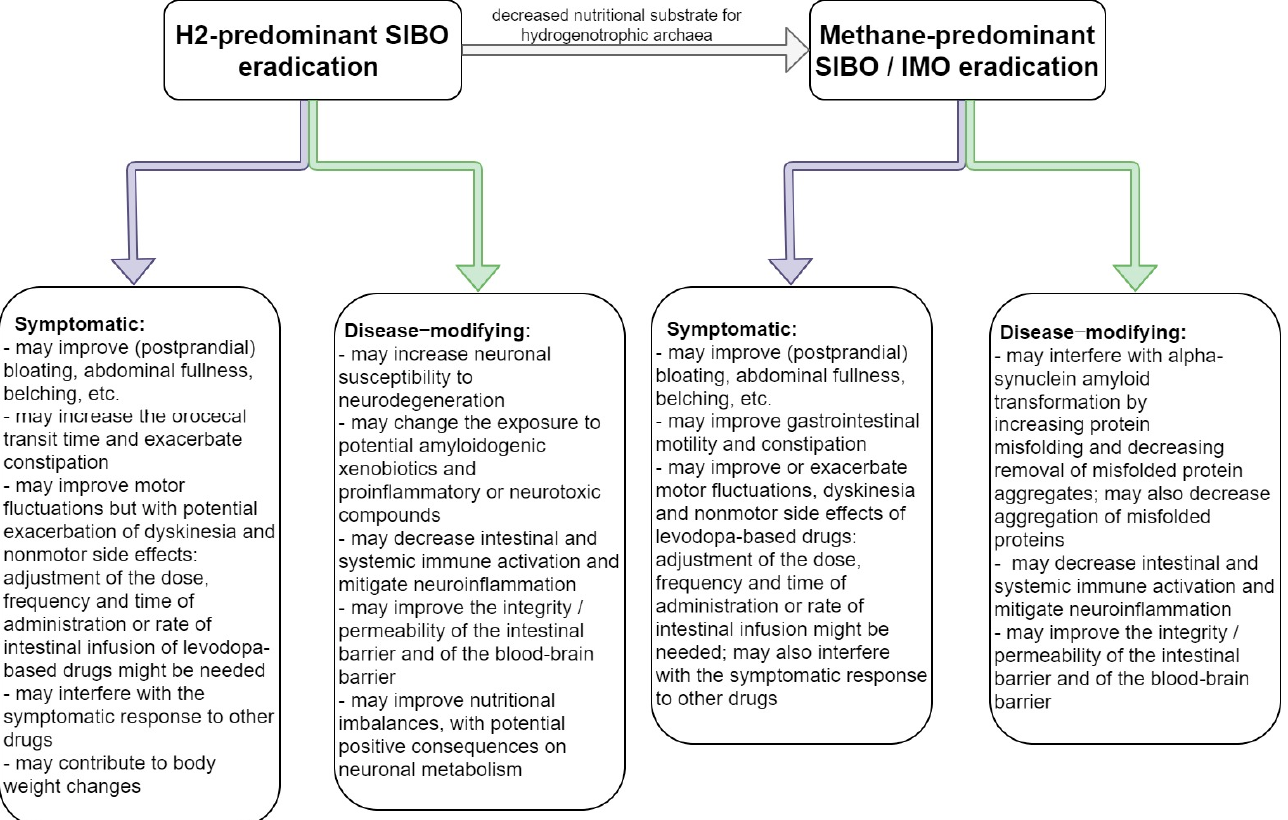
Figure 3. Expected effects of SIBO eradication in people with sporadic PD. The figure illustrates the potential symptomatic and disease-modifying consequences of SIBO eradication in people with sporadic PD. Noteworthy, interventions done for SIBO eradication would also interfere with the gastric and colonic gut microbiota. The effects of SIBO eradication and modulation require further investigation.